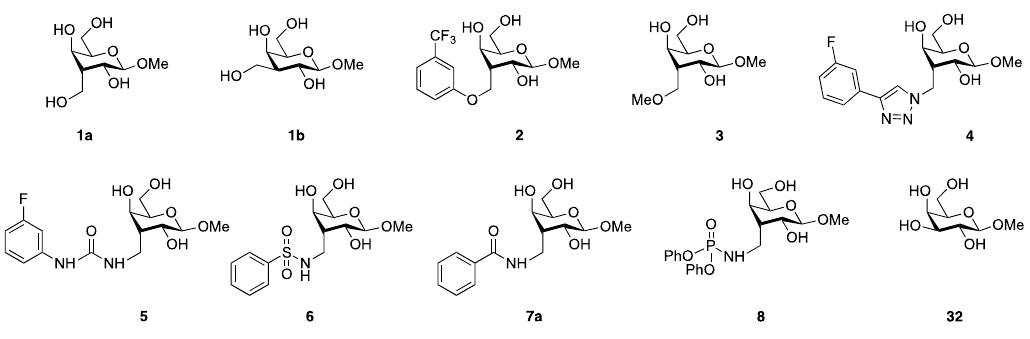
Figure 1. Structures of the tested compounds 1 – 8 and reference compound 32 .